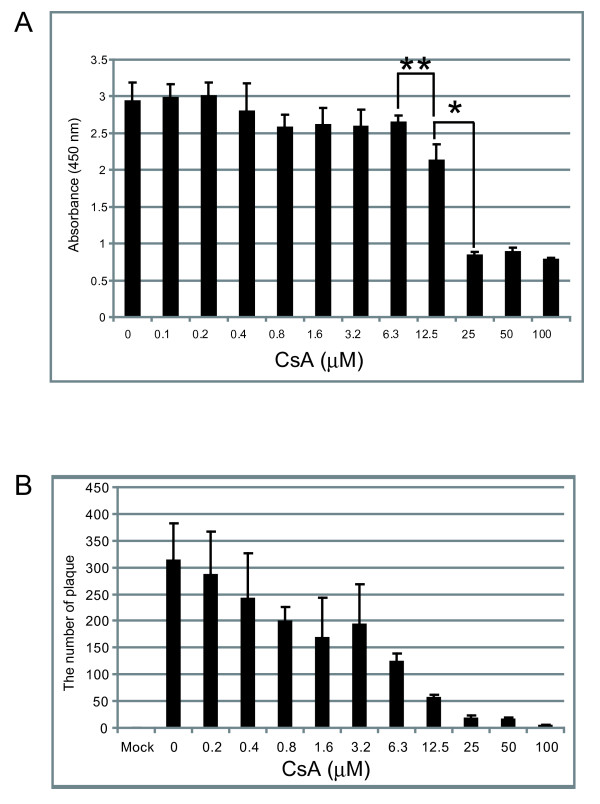
Cyclosporin A inhibits cytopathic effects of FIPV on fcwf-4 cells. (A) WST-8 assay of fcwf-4 cells cultured with indicated concentrations of CsA. Error bars indicate means ± 2SD. *P, **P < 0.05. (B) Plaques counted in FIPV-infected fcwf-4 cells incubated with or without CsA. Cells infected with FIPV were incubated with various concentrations of CsA.